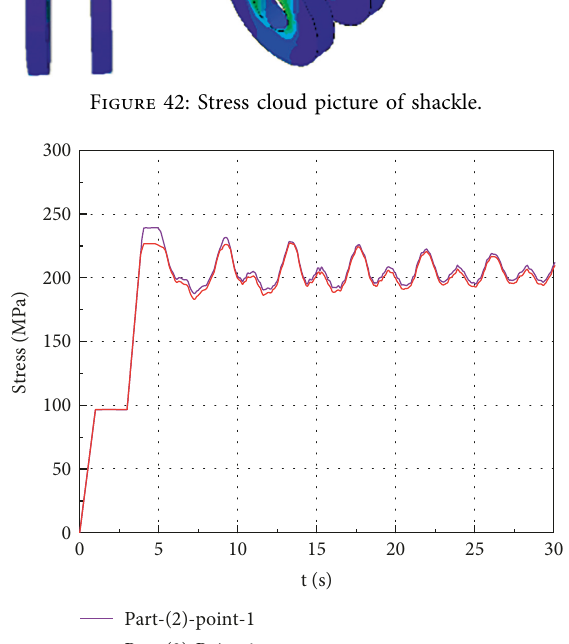
Figure 43: Stress-time curve of shackle.